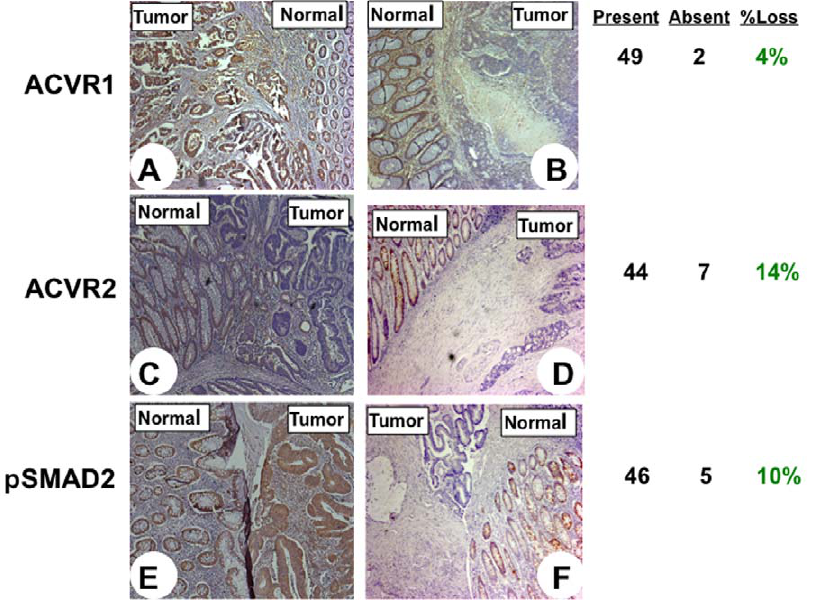
Figure 1. Loss of expression of three components of activin signaling in primary MSS colon cancers. Immunohistochemical analysis of paraffin-embedded primary colon cancers assessed expression of target protein (brown) as compared to adjacent normal tissue. A and B (Top row): ACVR1 expression is lost in a subset of MSS tumors. Example of tumor with expression in both normal and colon tumor tissue (left panel) and selective loss in a subset of tumors, but not adjacent normal colonic tissue (right panel). Overall, ACVR1 loss was observed in 2/51 or 4% of all MSS colon cancers analyzed. C and D (Middle row): ACVR2 expression is lost in a subset of MSS tumors. Two examples of selective loss of ACVR2 in colon tumor, but not normal colonic tissue (left and right panel) are shown. Overall, ACVR2 loss was observed in 7/51 or 14% of all MSS colon cancers analyzed. E and F (Bottom row): pSMAD2 expression is lost in a subset of MSS tumors. Example of expression in both normal and colon tumor tissue (left panel) and selective loss in a subset of tumors, but not normal colonic tissue (right panel). Overall, pSMAD2 loss was observed in 5/51 or 10% of all colon cancers analyzed.